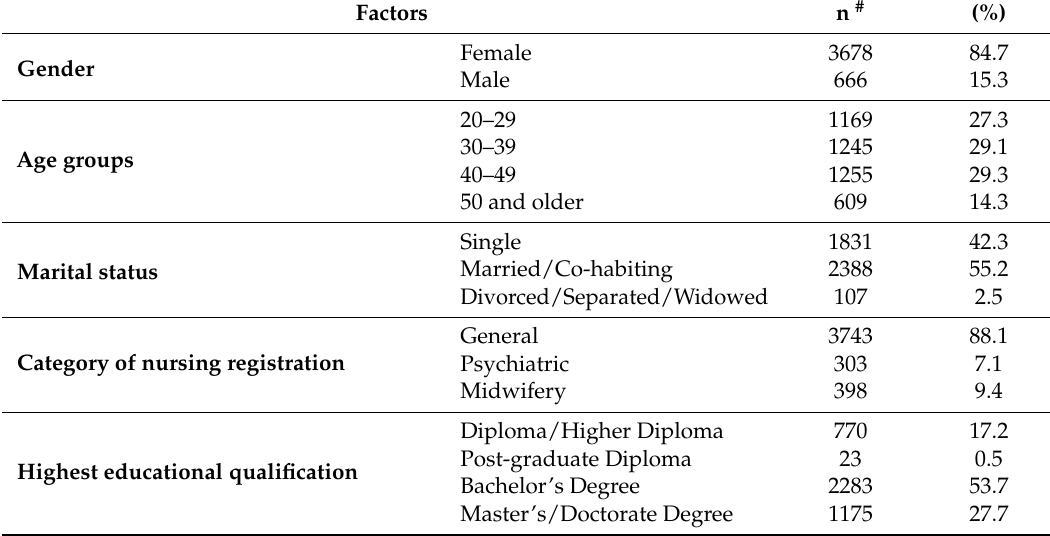
Table 1. Demographics of the nurses (N =